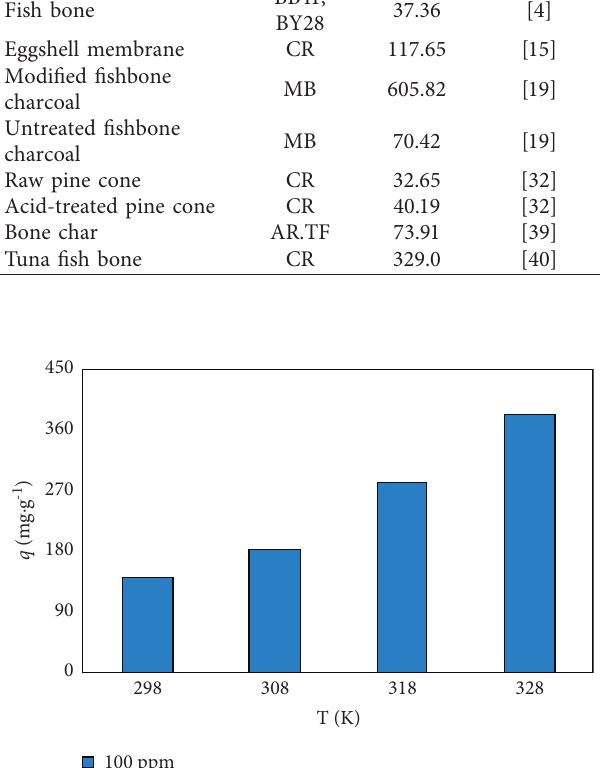
Figure 9: Effect of temperature on Congo red removal by fish bone